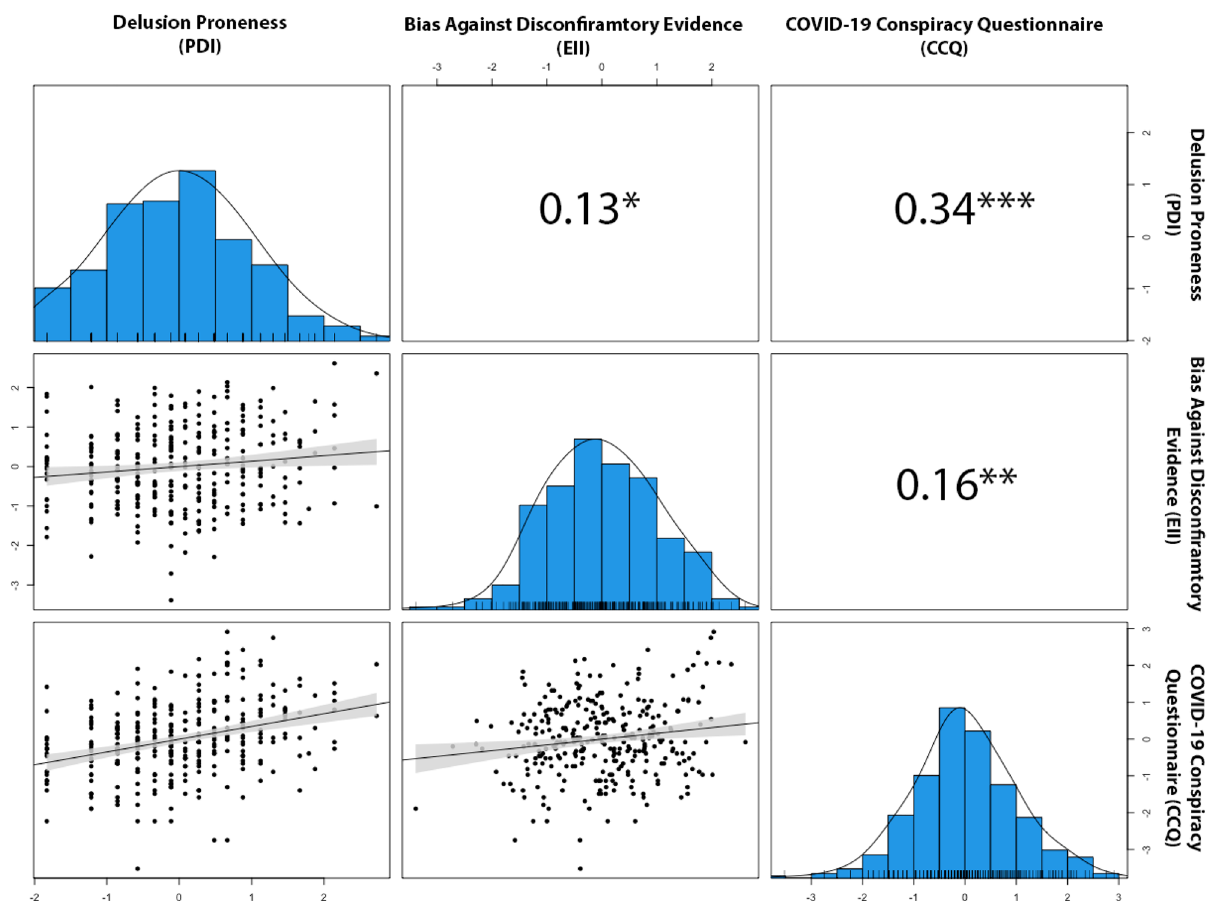
Figure 1. Pearson’s correlations with scatter and distribution plots of PDI, EII and CCQ total for subjects that completed BADE (N = 313); * p < 0.05, ** p < 0.01, *** p < 0.001. All variables were transformed to achieve